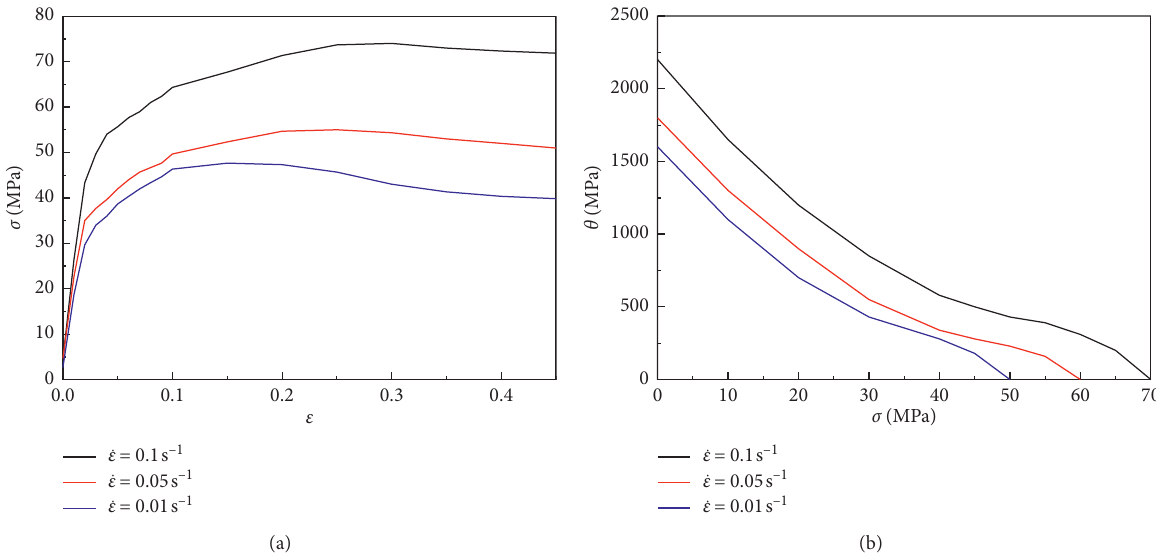
Figure 7: The true stress-strain and work-hardening rate curves of 06Cr strain curve. (b) The work-hardening rate curves.